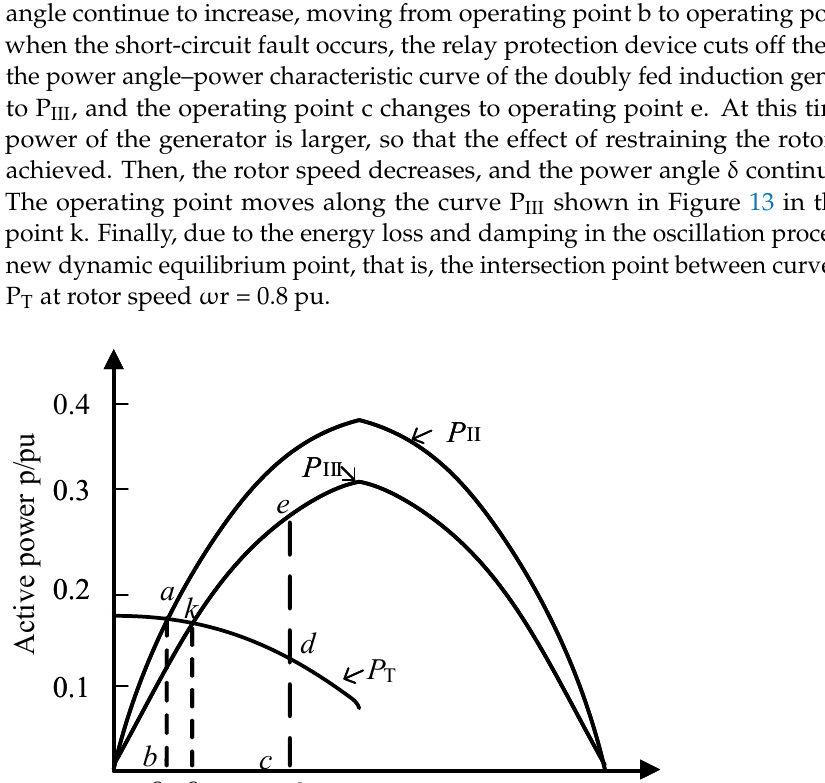
expressed by standard values, in which K G* =